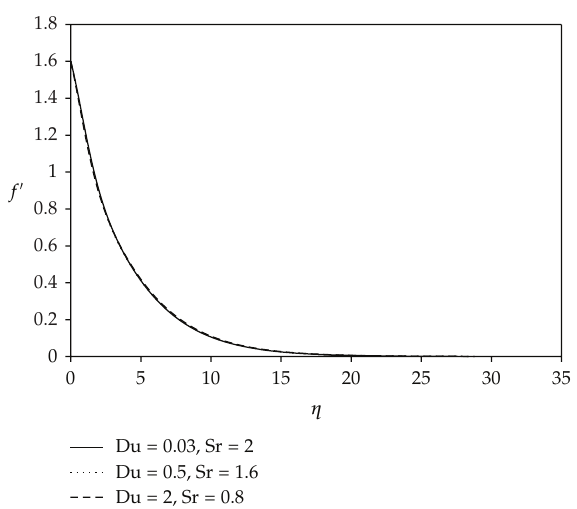
Figure 1: Velocity profile for di ff erent values of Dufour and Soret for θ r (cid:8) 5, N (cid:8) 1, Le (cid:8) 0 . 1, Pr (cid:8) 0 . 71, and Sc (cid:8) 0 .